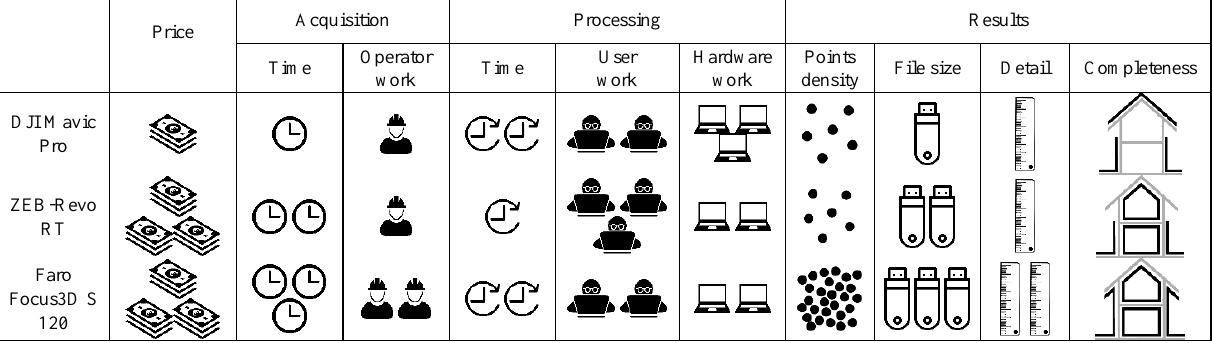
Table 14. Summary of the employed sensors evaluating different